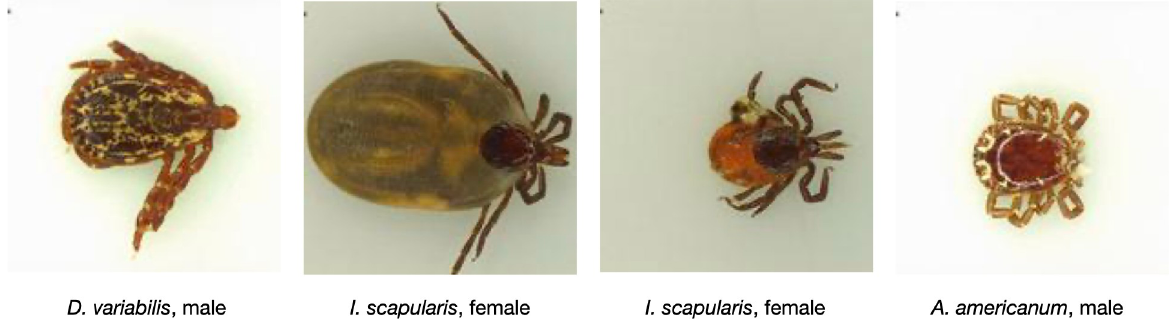
Fig 4. Representative images from the laboratory test set that includes high-quality images of tick specimens taken on a plain background. The laboratory test set includes male and female (fed and unfed) specimens of the three most common human-biting ticks in the U.S.. The laboratory test set was sourced from an online database maintained by tickreport.com; a tick identification and testing service.